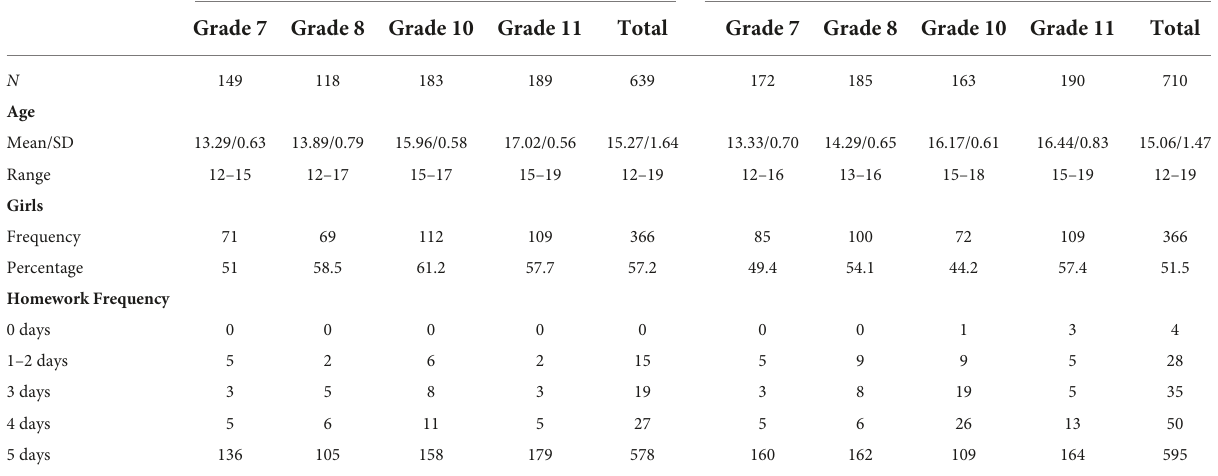
TABLE 1 Basic information of samples 1 and 2